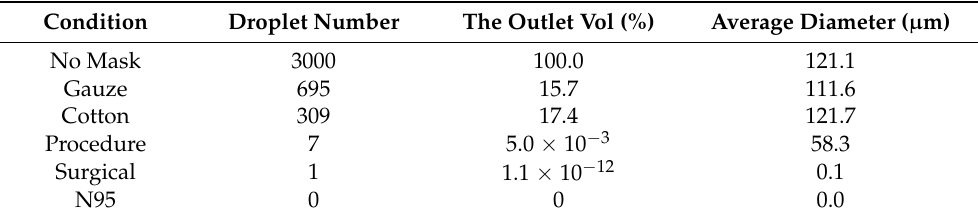
Table 3. The escaped droplet of the mask (depending on the training data pattern).